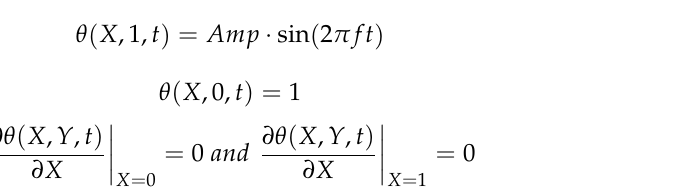
Figure 1. Physical model.